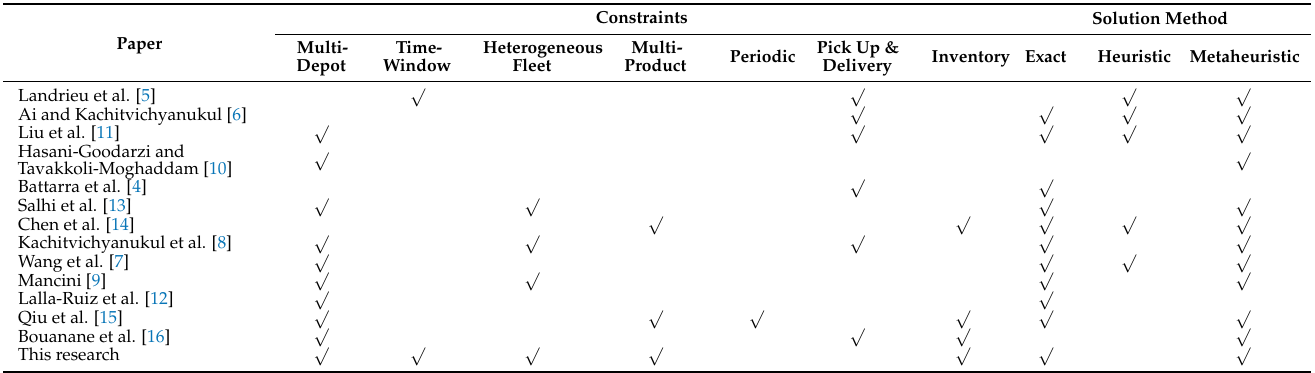
Table 1. Summary of literature for the